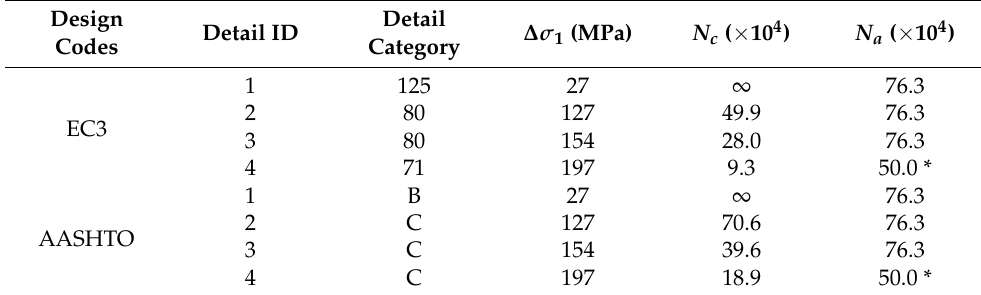
Table 1. Fatigue life assessment of the fatigue details.